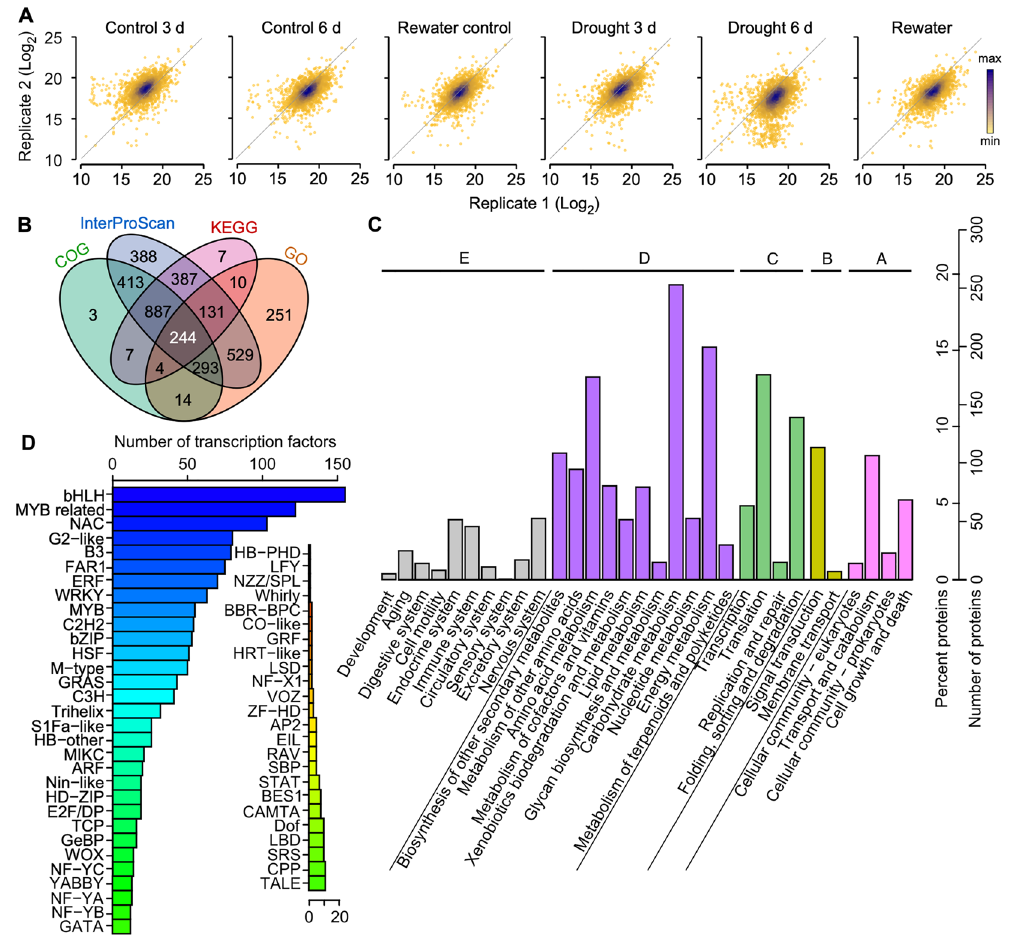
Figure 1. Basic iTRAQ output details. ( A ) Scatter plots showing the correlation between two replicates for different conditions. ( B ) Venn diagrams of the identified peptides using different annotation techniques. ( C ) The KEGG annotation for the identified peptides. ( D ) Frequency of each transcription factor class in the identified